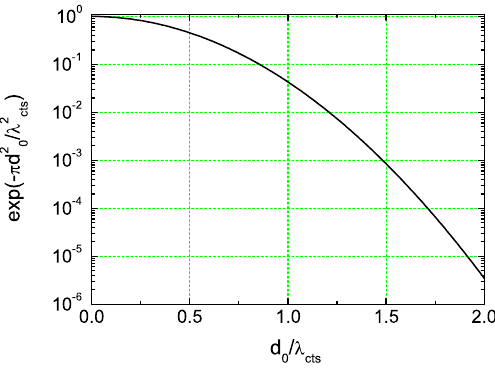
FIG. 5. RES reflectivity as a function of RES thickness d 0 divided by CTS wavelength (cid:6) cts in the lab